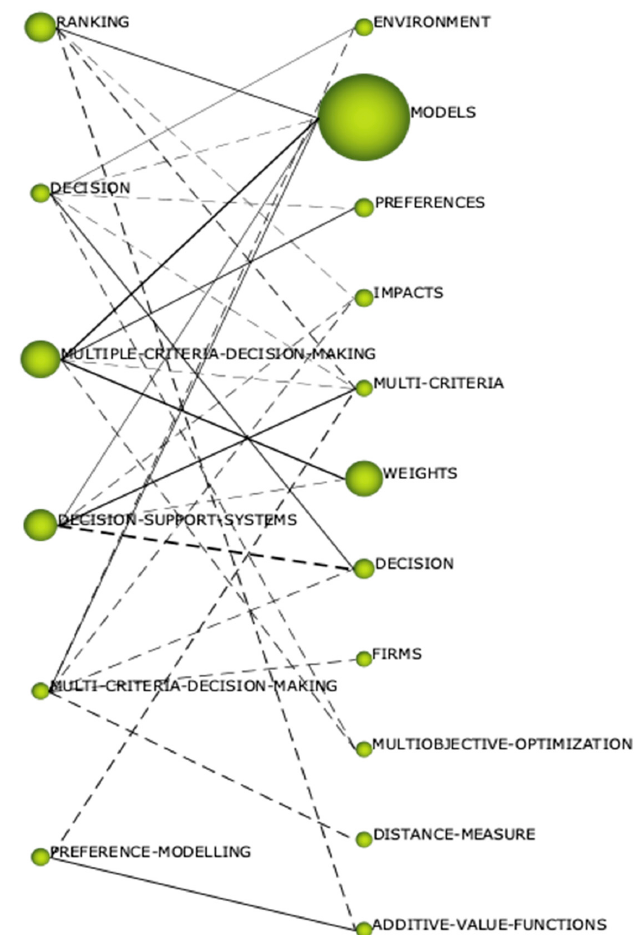
Figure 10. Evolution map. Subperiod 1 (1979–2008) vs. subperiod 2 (2009–2022).